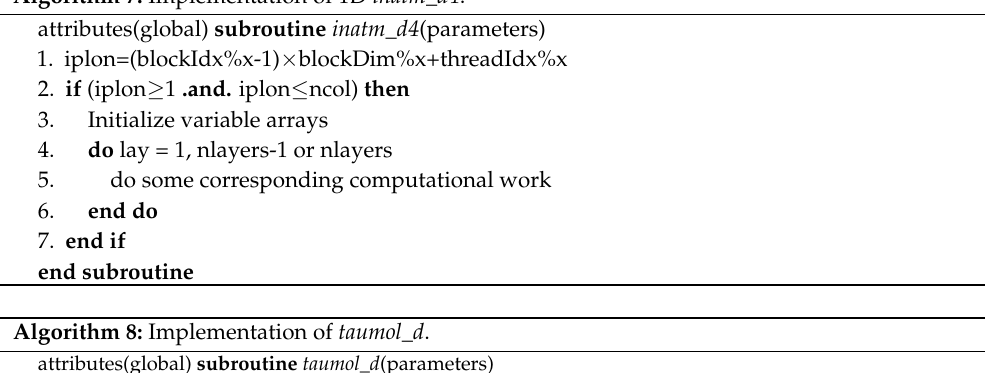
Algorithm 8: Implementation of taumol_d